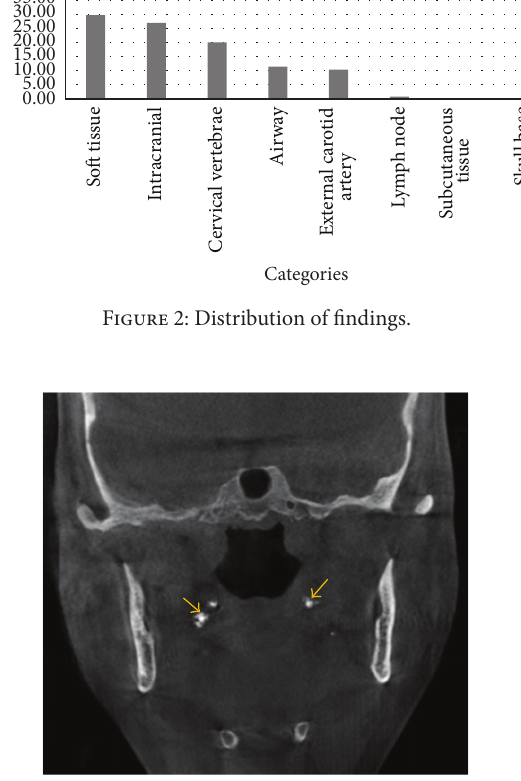
Figure 3: A coronal view shows tonsilloliths within the